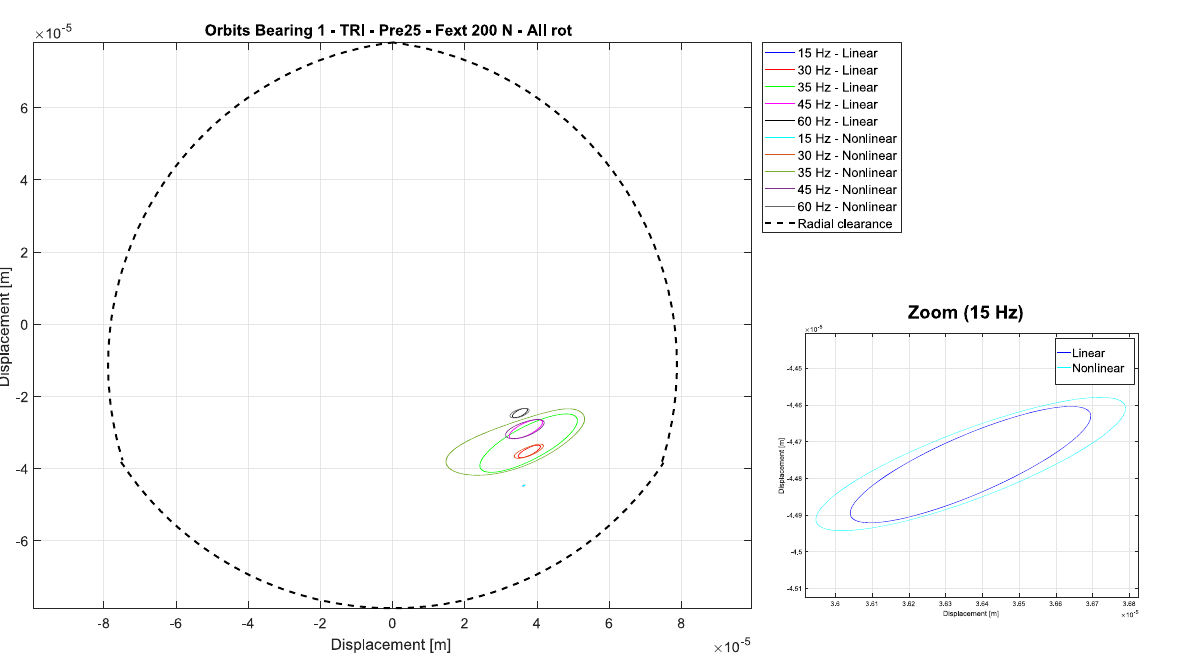
Figure 7. Orbits for all rotations simulated in three-lobed bearing 1 (preload 0.25), with zoom in rotation 15 Hz.